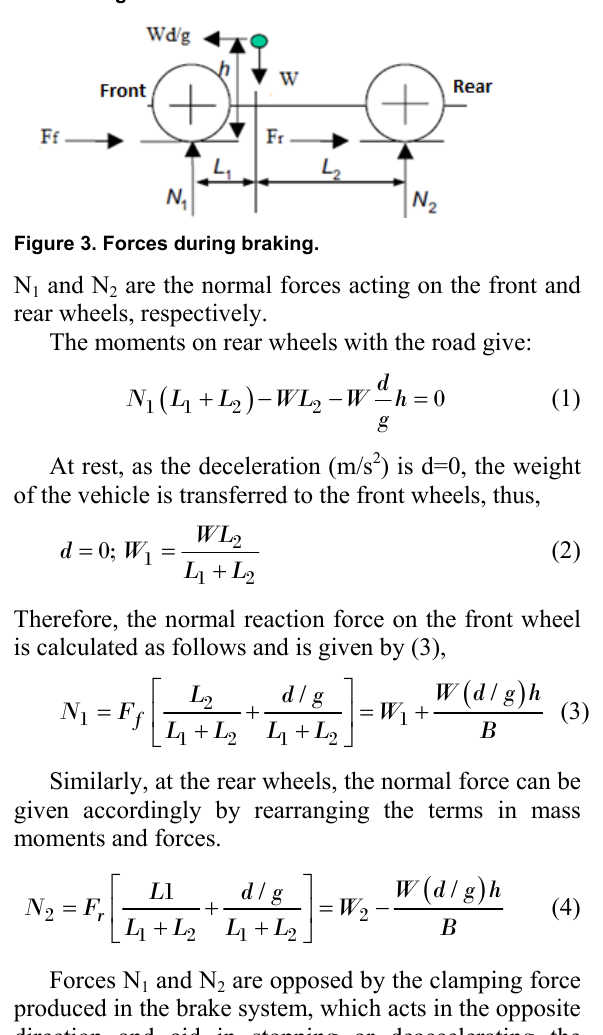
Figure 2. Dynamic effect on the vehicle during the static and braking conditions